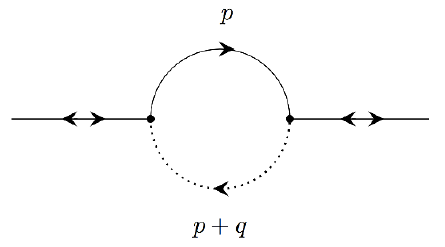
Figure 2 . The photino self-energy at